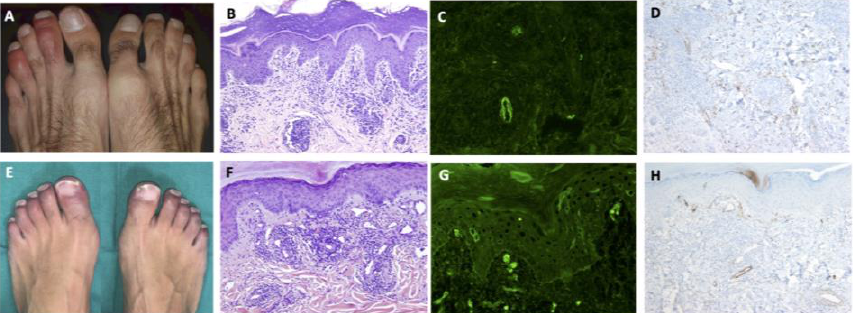
Figure 3. Clinical, histologic, and immunopathologic features of two cases with chilblain-like lesions. ( A ) Patient 2 Table S1. Painful chilblain-like lesions on toes; ( B ) Lichenoid dermatitis with perivascular and periadnexal lymphocytic infiltration on superficial and deep dermis. (Hematoxylin and eosin stain, original magnification × 100); ( C ) Granular IgM deposition in dermal vessels (Direct immunofluorescence, original magnification × 200); ( D ) C9 reactivity in dermal vessels (Immunohistochemistry, original magnification × 100); ( E ) Patient 8 Table S1. Chilblain-like violaceus lesions on toes; ( F ) Perivascular and perianexial lymphocytic infiltration on superficial and mid dermis. (Hematoxylin and eosin stain, original magnification × 100); ( G ) Granular C3 deposition in superficial dermal vessels (Direct immunofluorescence, original magnification × 200); ( H ) C9 reactivity in dermal vessels (Immunohistochemistry, original magnification × 100). Skin biopsies were performed in 42 (72%) patients and included DIF in 30 (52%), and IHC in 35